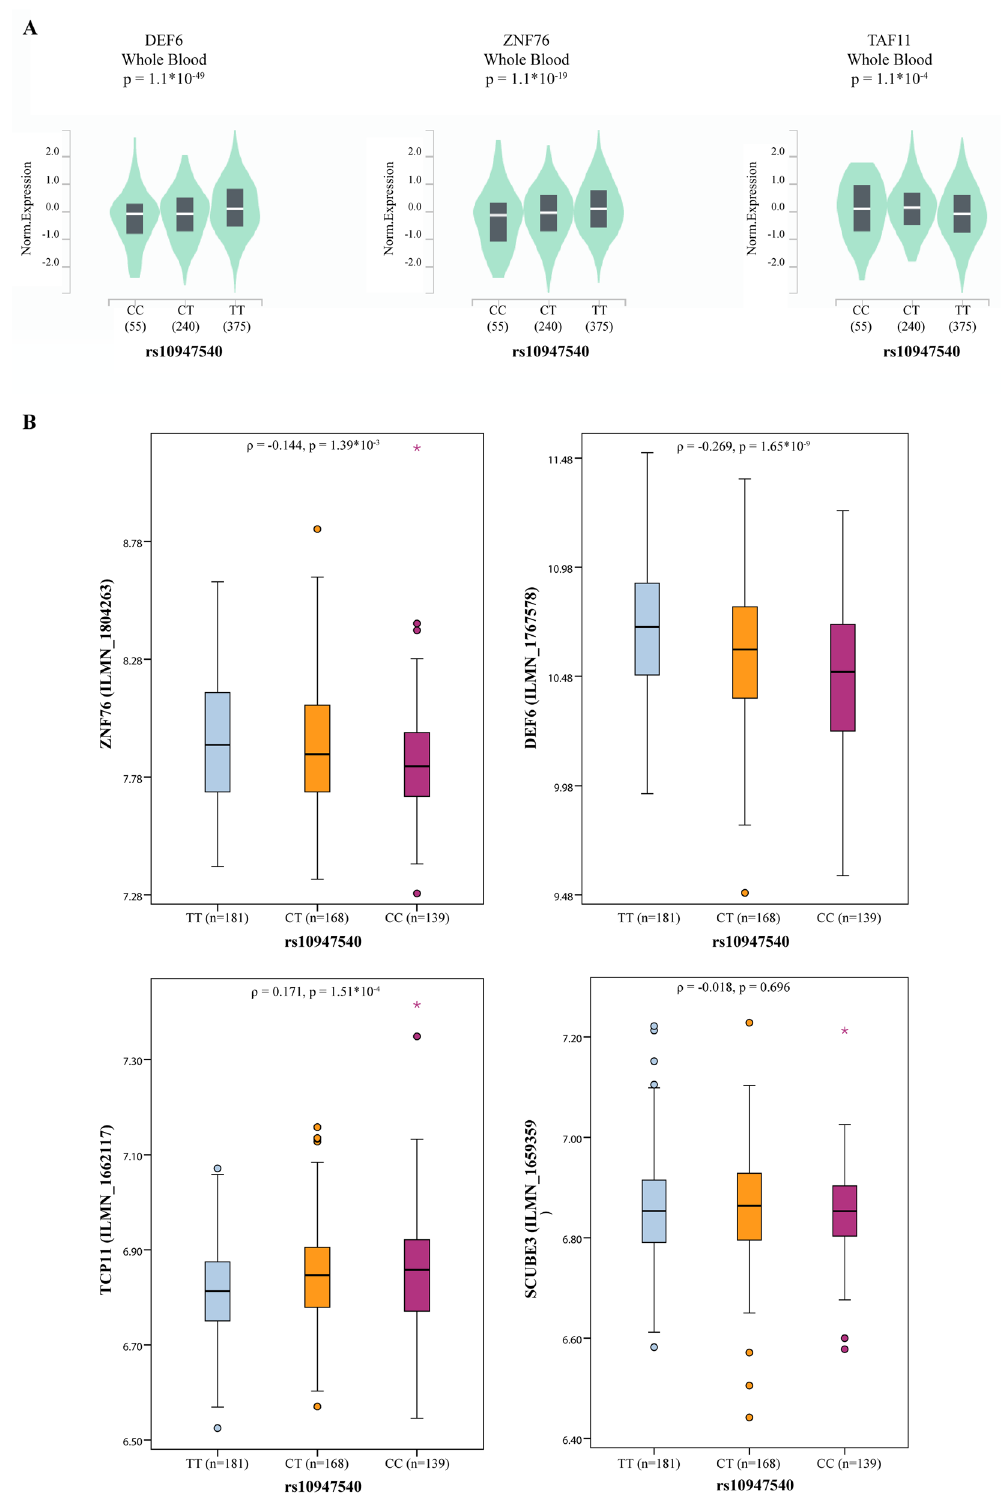
Figure 3. The integrated expression and genotypic analysis of ZNF76 rs10947540. ( A ) The violin plot for expression of DEF6 , ZNF76 , and TAF11 in whole blood were obtained from GTEx database. ( B ) The correlation between ZNF76 , DEF6 , TCP11 , and SCUBE3 and rs10947540 genotypes were adopted in E-MTAB-264 and the significances were tested by spearman’s correlation coefficient. The boxplot was generated via boxplot in